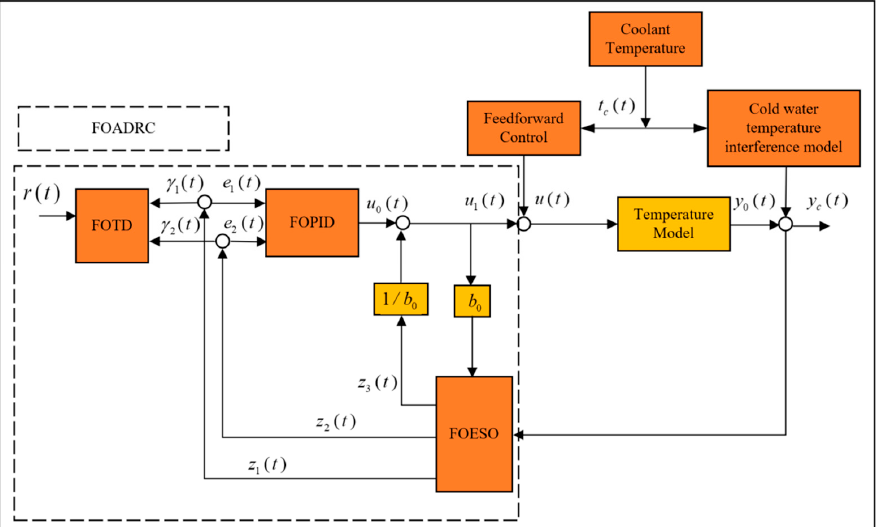
Figure 6. Fractional order feedforward self-turbulence control system.